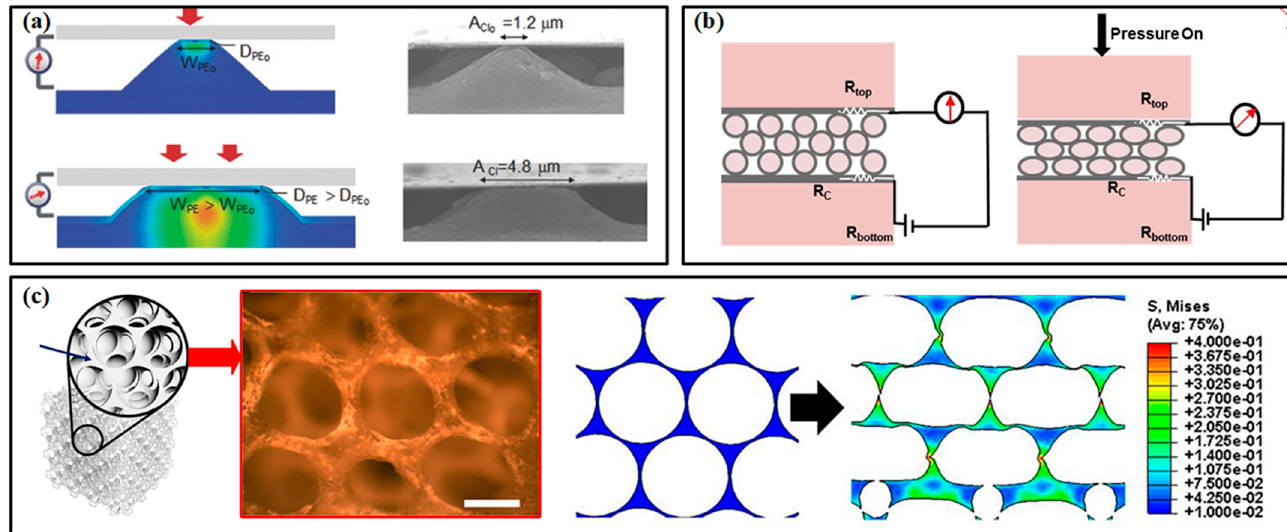
Figure 7. The high-performance pressure sensors with engineered structures: ( a ) pressure sensor with micropatterned layer [96]; ( b ) pressure sensor with multilayered structure; ( c ) pressure sensor with porous layer [98] . Reproduced with permissions from Wiley (2014)[96]. Reproduced with permissions from Elsevier (2018)[97]. Reproduced with permissions from American Chemical Society (2019)[98].